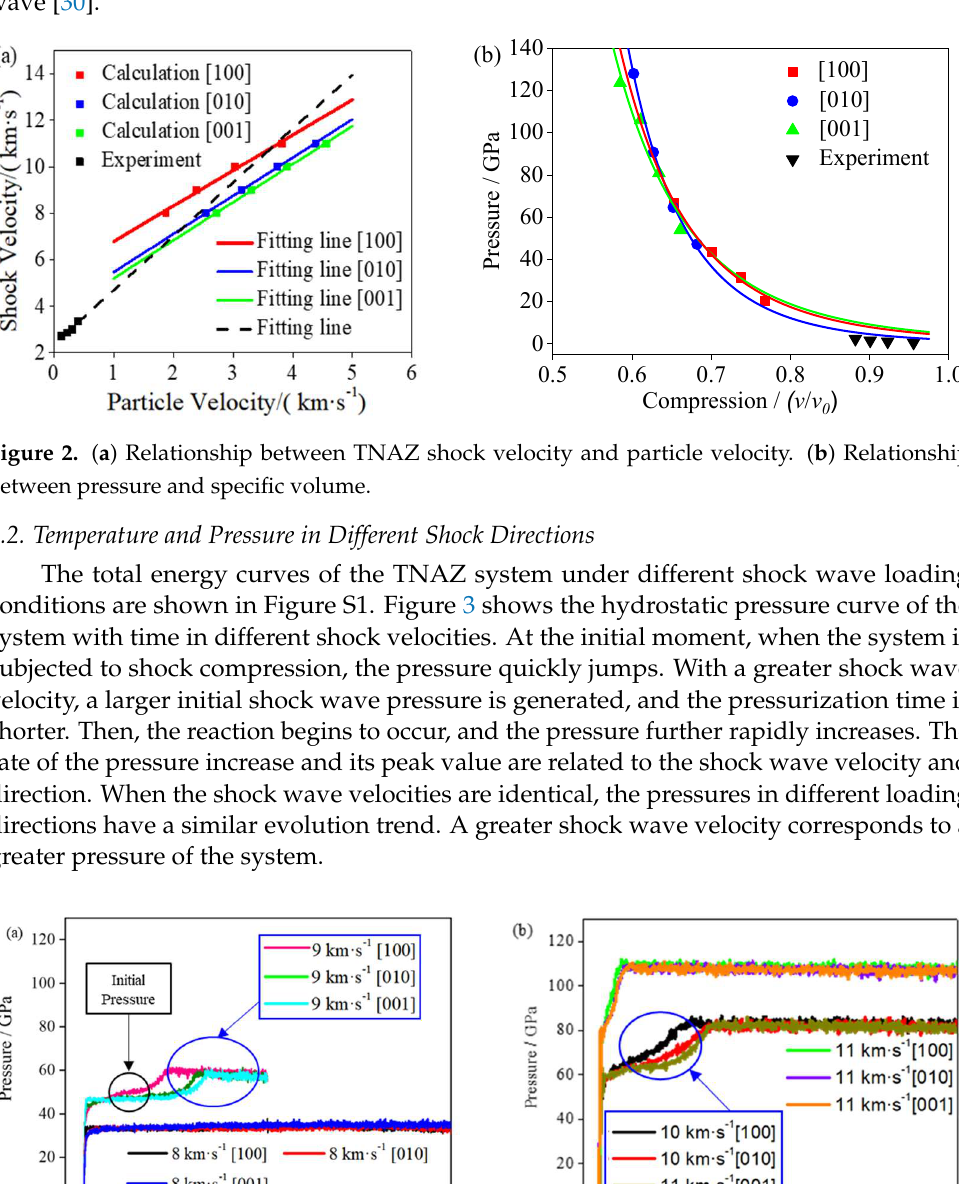
Figure 3. ( a ) Evolution of pressure at 8 and 9 km∙s −1 . ( b ) Evolution of pressure at 10 and 11 km∙s −1 .